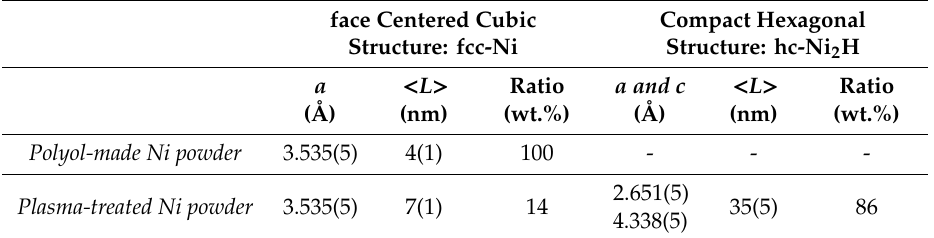
Figure 1. Experimental (black scatter) and calculated (red line) X-ray diffraction (XRD) patterns of polyol-made ( a ) and plasma treated ( b ) Ni powders. The residue, defined as the difference between the experimental and calculated diffractograms, is given (blue line) to illustrate the fit quality, with a Bragg reliability factor R B ranging between 1.5 and 2.0. Table 1. Main structural and microstructural characteristics of the produced powders as inferred from XRD analysis. Typically the cell parameter a , the average size of the coherent diffraction domains < L > and the weight ratio of each identified crystalline phase are given.